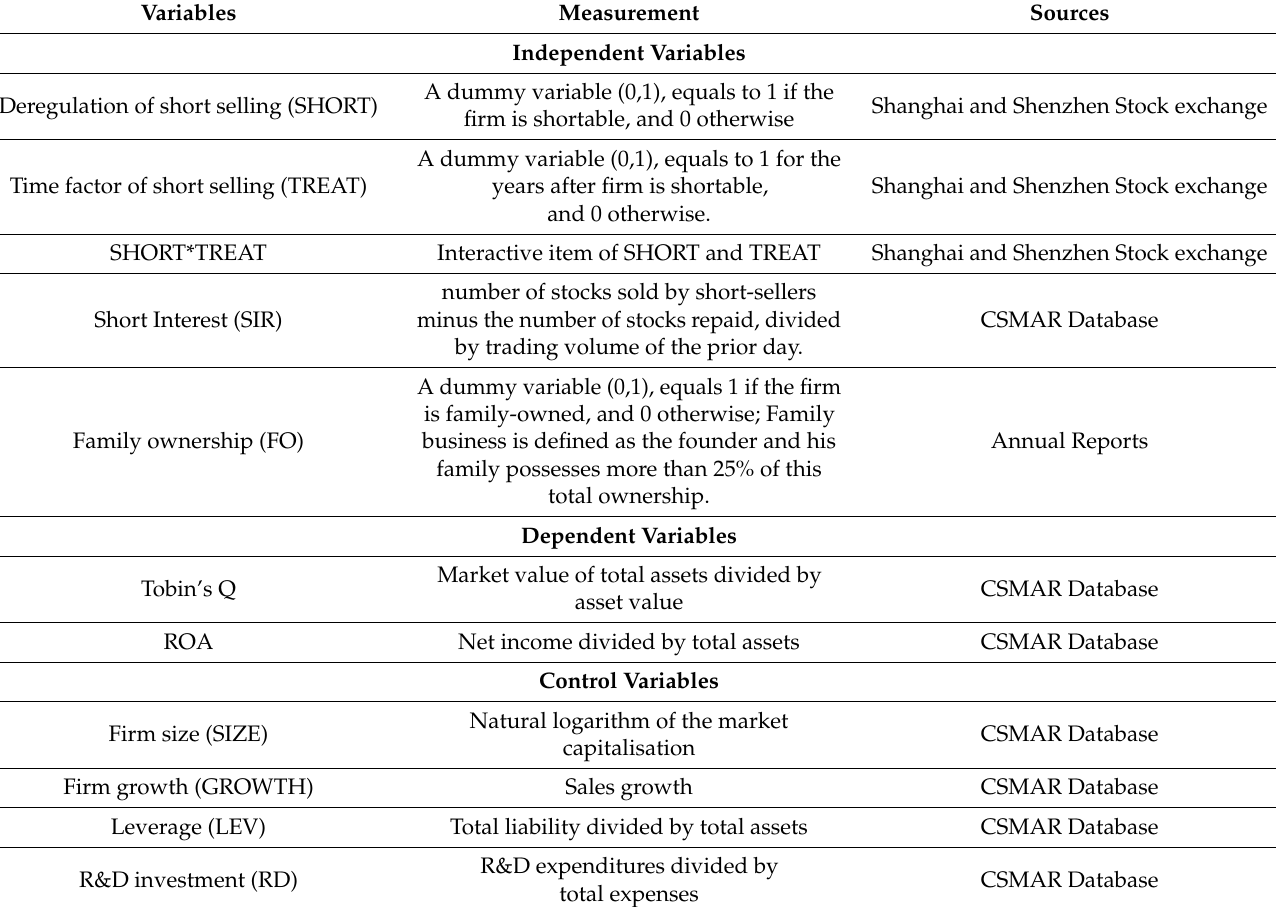
Table 1. Description and measurement of